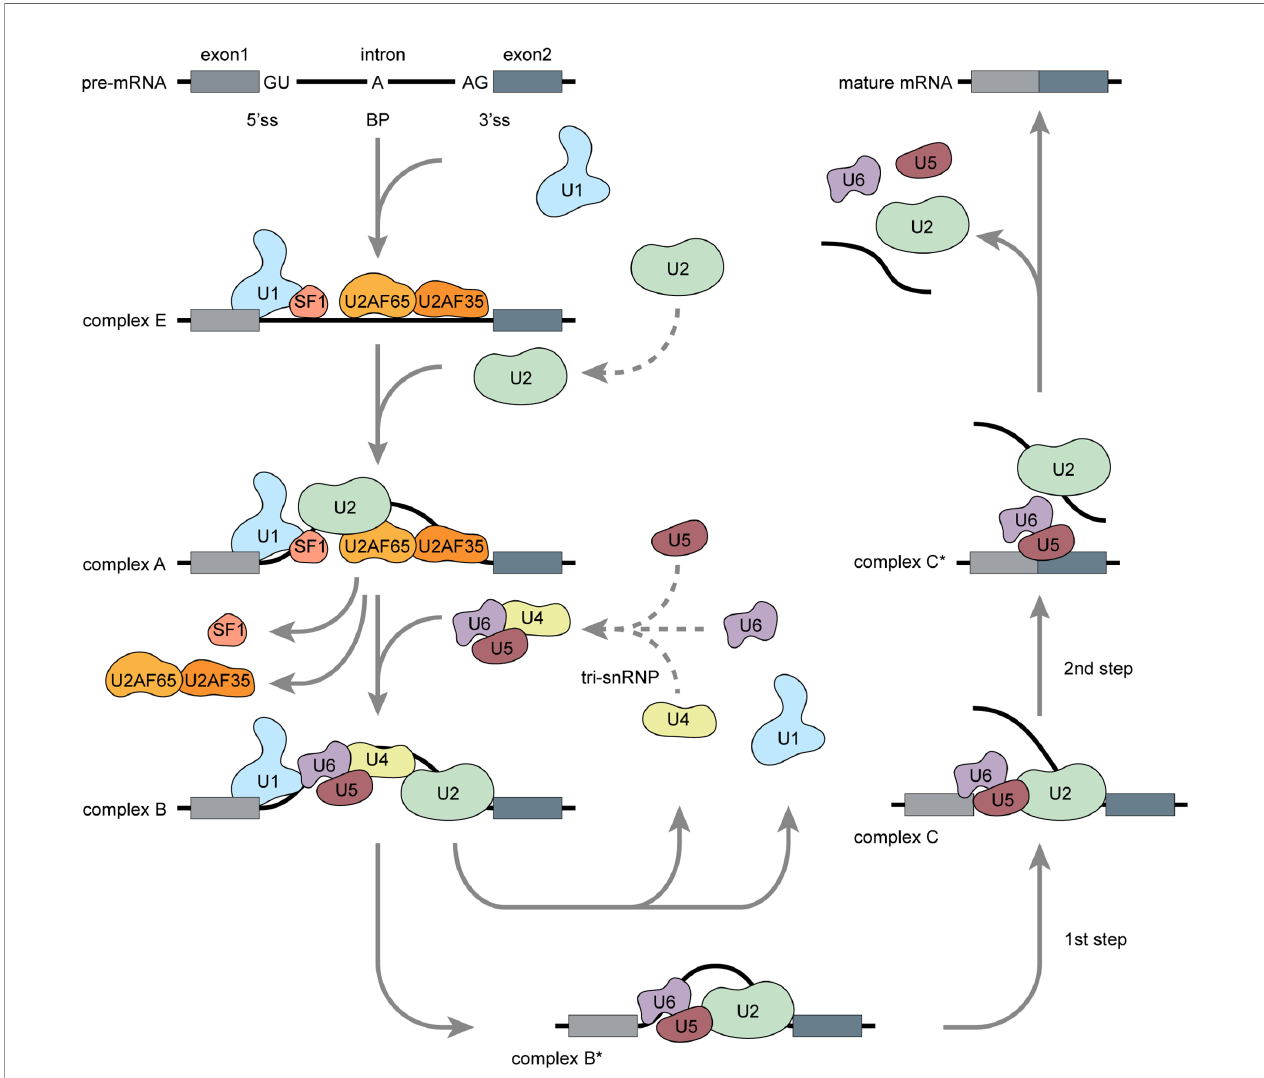
FIGURE 1 | Pre-mRNA splicing: Spliceosome assembly (Adapted from Matera AG, Wang Z. A day in the life of the spliceosome. Nat Rev Mol Cell Biol (2014) 15:108-21). Pre-mRNA splicing occurs in several spliceosome assembly steps. Splicing begins with U1 snRNP assembly onto pre-mRNA via 5 ’ ss recognition and subsequent combination with U2AF and SF1 to form early complex E. Then, U2 snRNP replaces SF1 at the branch point and forms a pre-spliceosome (complex A). Pre-assembled U4/U6 – U5 tri-snRNP complexes are then recruited to form catalytically active complex B, which is then converted into catalytically active complex B* via release of U1 and U4. Through two catalytic steps and conformation or composition rearrangements, complex B* converted into a fi nal complex C* and U2, U5, and U6 are released from the spliceosome followed by intron excision, exon ligation, and mature mRNA